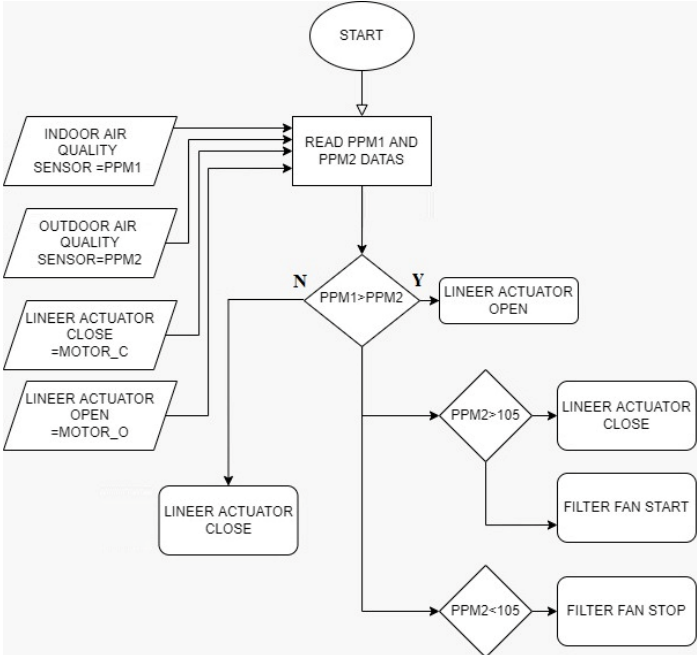
Figure 8. The basic algorithm of the software of the natural ventilation system .